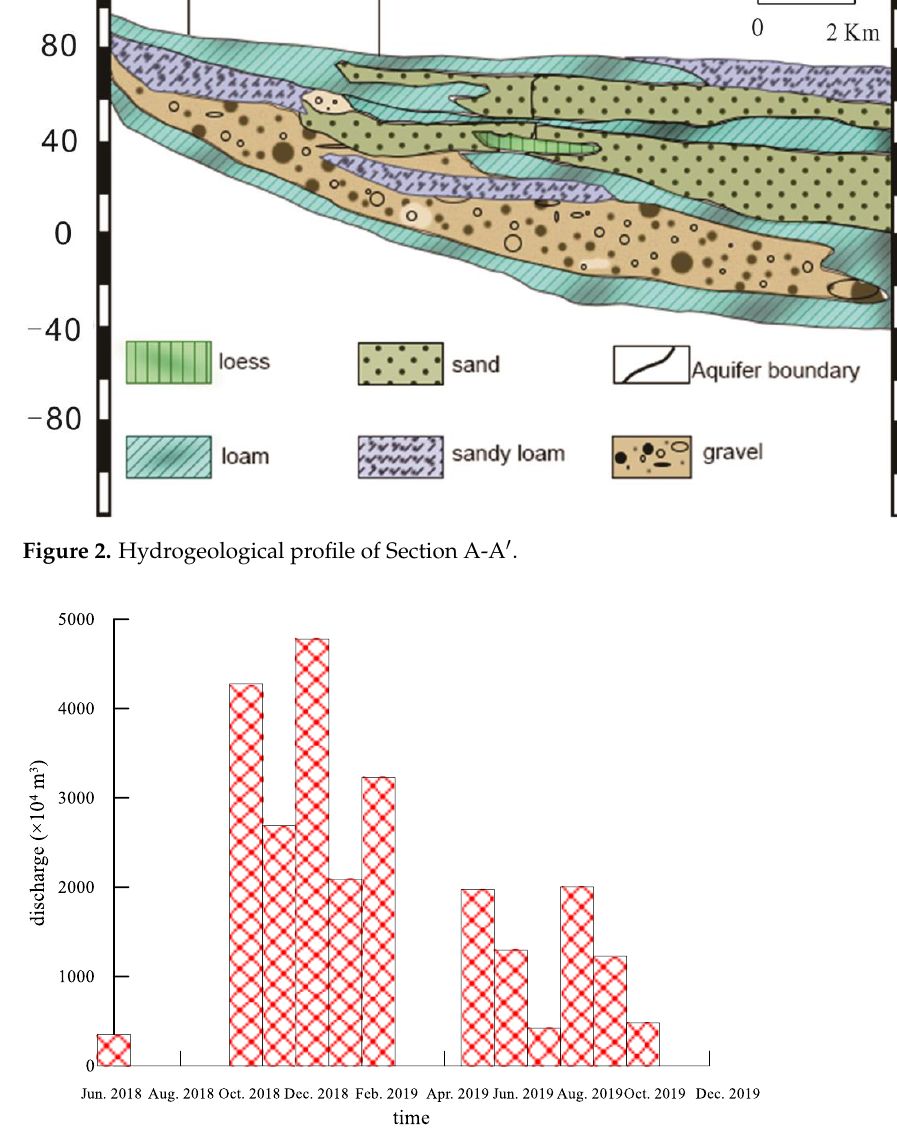
Figure 3. Amount of monthly reservoir discharge.